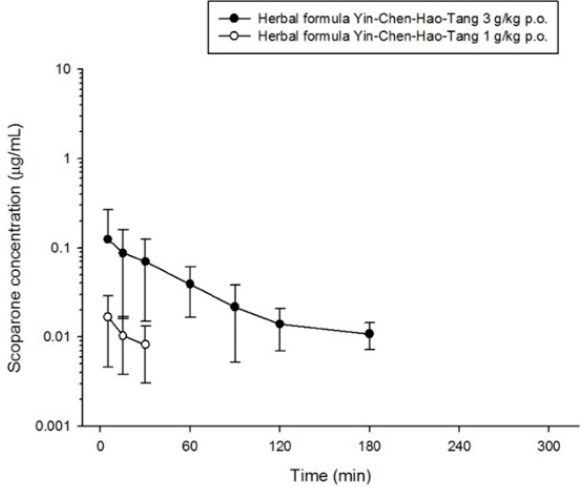
Figure 3. Concentration-time profile of scoparone in rat plasma following oral administration of different dose of herbal formula (1 g/kg p.o. or 3 g/kg p.o. Yin-Chen-Hao-Tang).